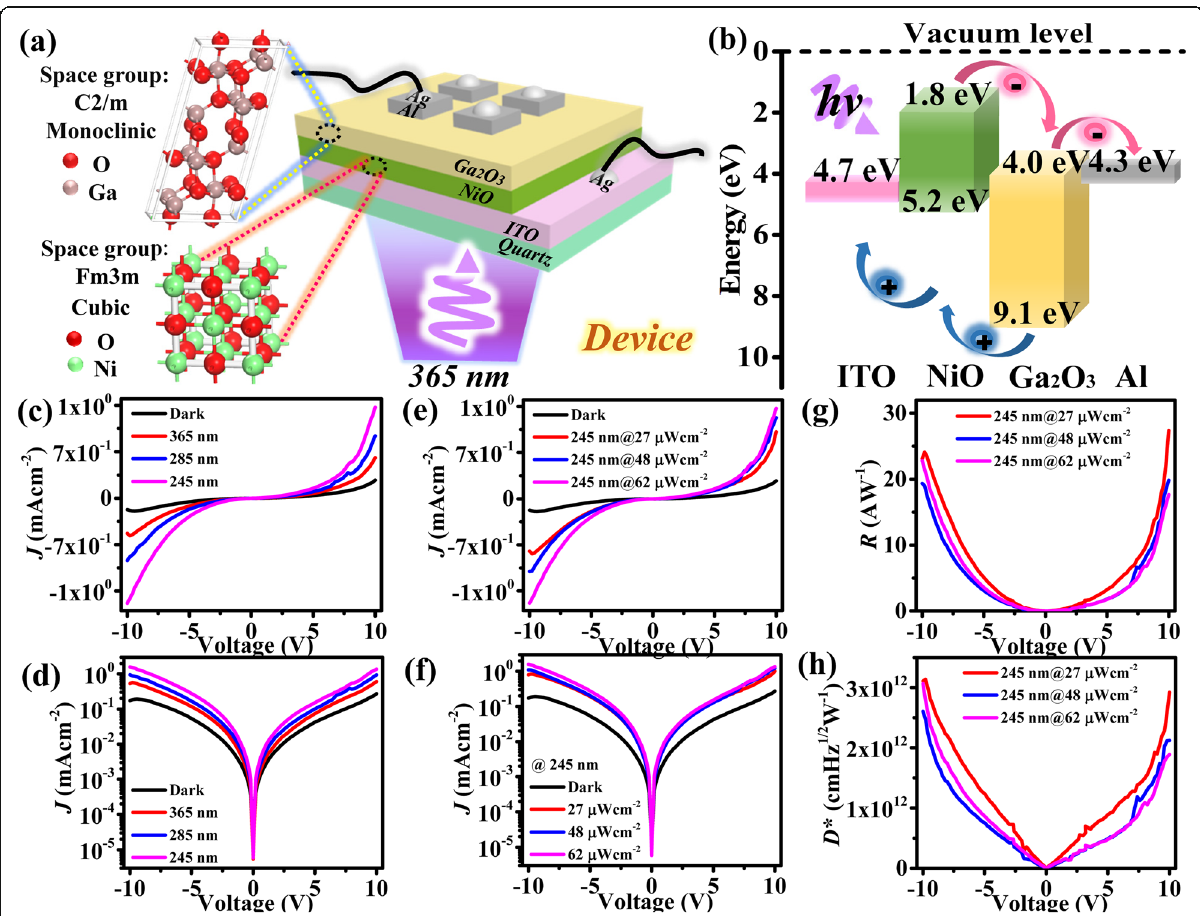
Fig. 3 a Schematic diagram showing the device structure consisting of ITO/NiO/ β -Ga 2 O 3 /Al. b Energy band diagram of the photodetector. c – d Measured J-V and log J-V curves, respectively, of the photodetector illuminated with a light of different wavelengths, and under dark conditions. e – f Measured J-V and log J-V curves, respectively, of the photodetector under an UV illumination of 245 nm with different power density. g – h Responsivity ( R ) and detectivity ( D *), respectively, of the photodetector at different bias voltages under 245 nm light illumination